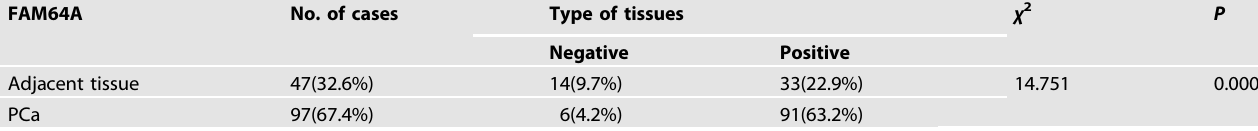
Table 1. Expression of FAM64A in PCa and adjacent normal prostate tissues.